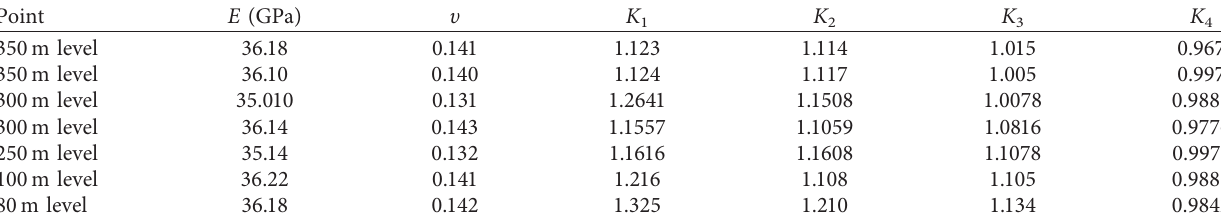
Table 2: Elastic modulus and Poisson’s ratio at each measuring